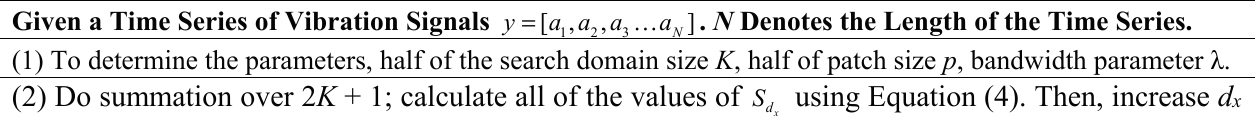
Table 1. The process of fast